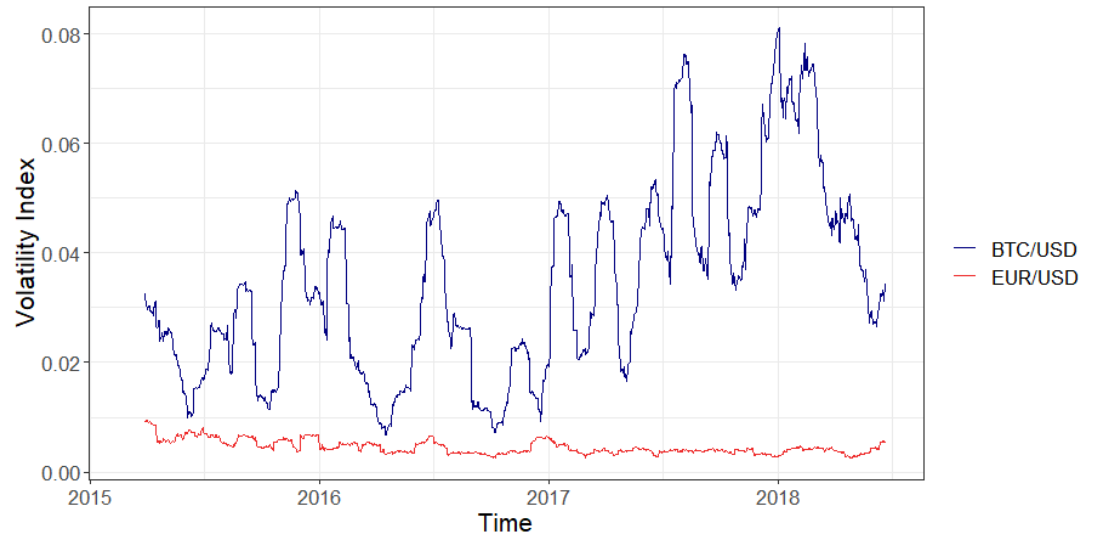
Fig. 1. Rolling 30-day volatility index calculated on the daily percentage returns of the Bit- coin/Dollar and Euro/Dollar rates of